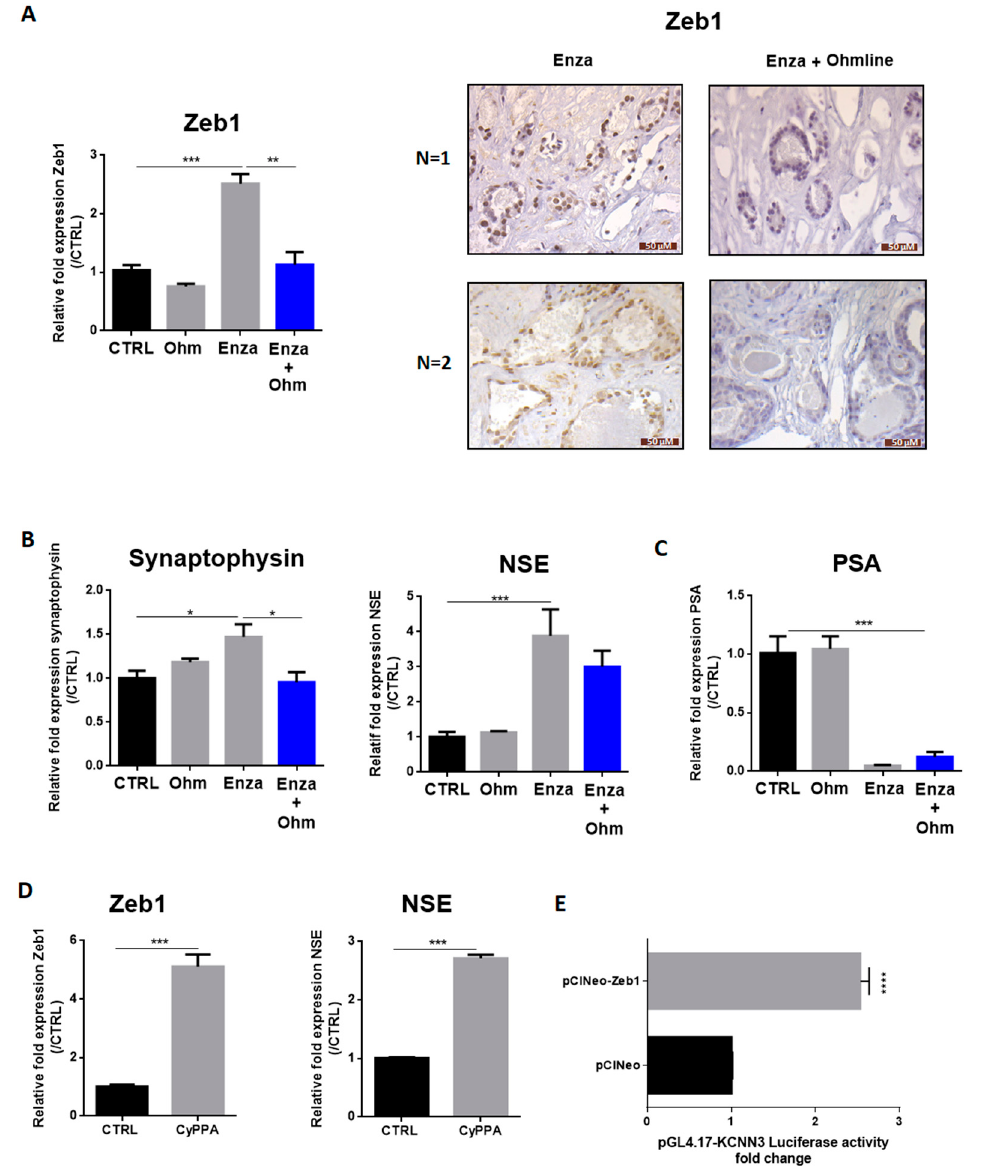
Figure 5. AR inhibition-induced NED depends on the SK3 potassium channel. ( A – C ): LNCaP cells were treated by Enza (10 µM) alone, with Ohmline (Ohm) alone or co-treated with Enza (10 µM) + Ohmline (1 µM) for 1 week. Immunohistochemical staining of Zeb1 (A) was performed in human PCa samples treated with Enza (10 µM) alone for 5 days or co-treated with Enza (10 µM) + Ohmline (1 µM) for 5 days; ( D ): LNCaP cells were treated (or not) with CyPPA (10 µM) for 1 week. Graphs represent qPCR results and pictures represent immunohistochemistry results. qPCR results are normalized to the control condition and are expressed as mean ± S.E.M; ( E ): Overexpression of Zeb1 enhanced KCNN3 gene transcription in LNCap cells. LNCaP cells were co-transfected with pGL4.17-KCNN3, pRL-TK and pCIneo (control condition) or pCIneoZeb1. Dual-luciferase reporter assays were performed 48 h after transfection. Results are normalized to the control condition and are expressed as mean ± S.E.M. The statistical differences are indicated: * p < 0.05; ** p < 0.01; *** p < 0.001 ( A – C